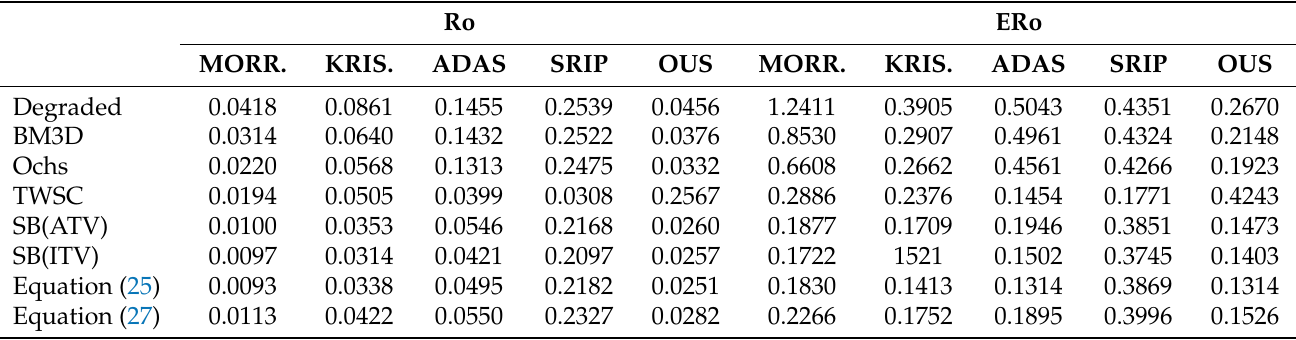
Table 6. Thermal image denoising using real-world images with the conventional algorithms. Performances of each algorithm have been measured by no-reference image